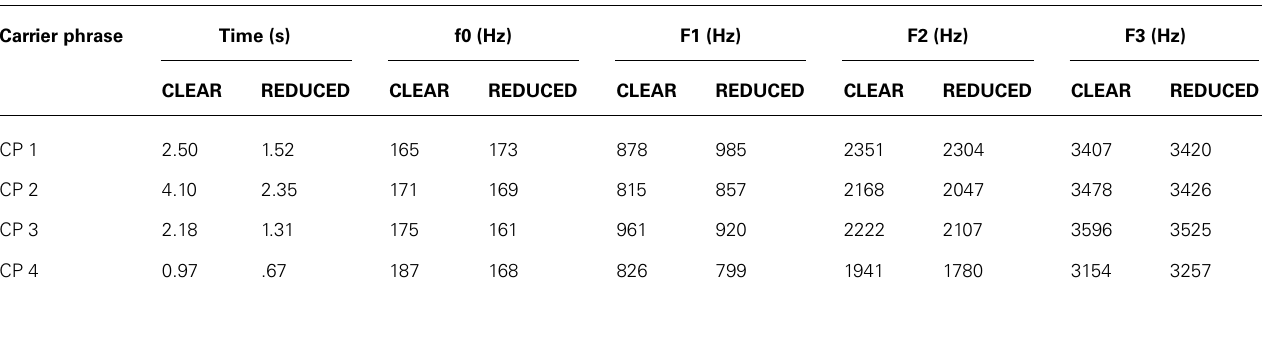
Table 1 | Duration of carrier phrases in seconds and average fundamental frequency, F1, F2, and F3 in both reduced and clear speaking styles. Carrier